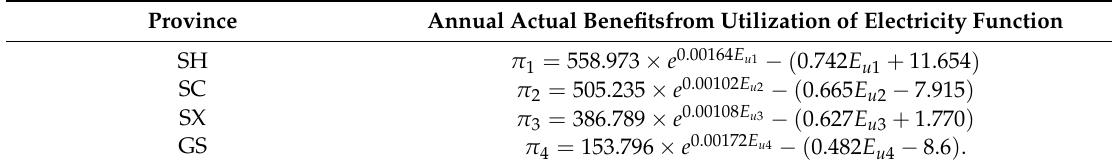
Table 9. Functions for the annual actual benefits from utilization of electricity.